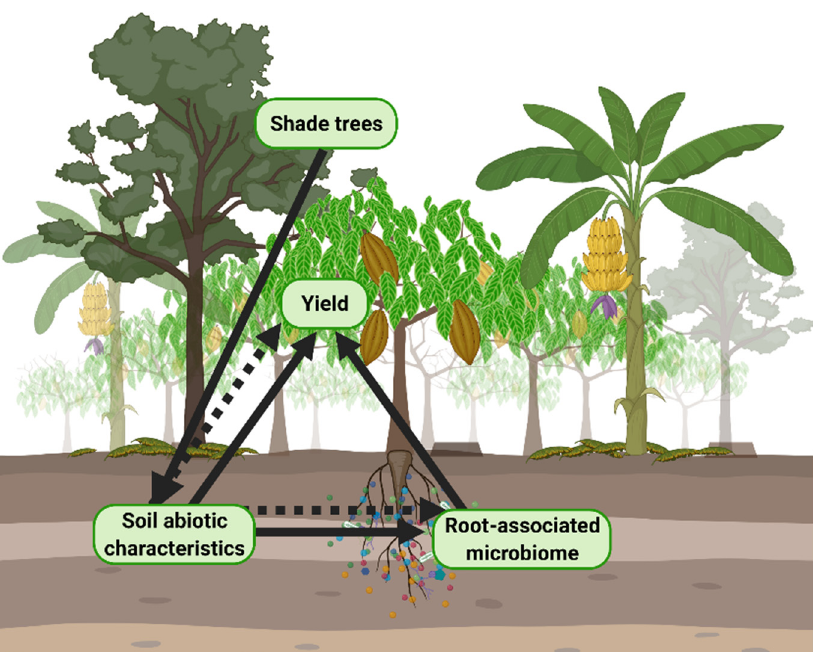
Figure 7. Relationships among shade trees, soil physicochemical properties, root-associated microbial communities, and cacao yields in this study. Shade trees had direct impacts only on soil physicochemical properties, specifically increasing pH and P while altering N speciation. However, shade trees also affected yield and microbial communities indirectly via their influence on soil properties, as soil N impacted yield, P affected fungal richness, and pH affected bacterial and fungal commu- nity composition. Other soil properties not influenced by presence or identity of shade trees also impacted yield and microbial communities. Microbial diversity and community composition were both important variables in predicting cacao